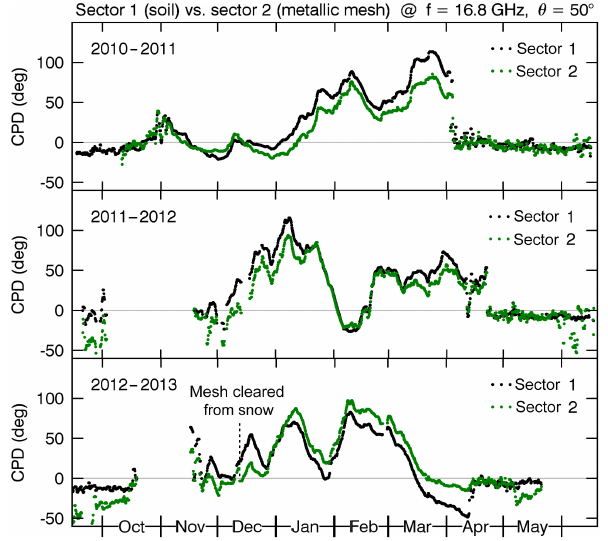
Figure 19. Comparison of CPD measurements from the two sectors of the test site. Sector 2 (green) was located between trees behind the SSI and was covered with a metallic mesh during the last two seasons of the experiment (after August 2011). Generally, the CPD of sector 2 evolves very similar to sector 1 and shows no large de-